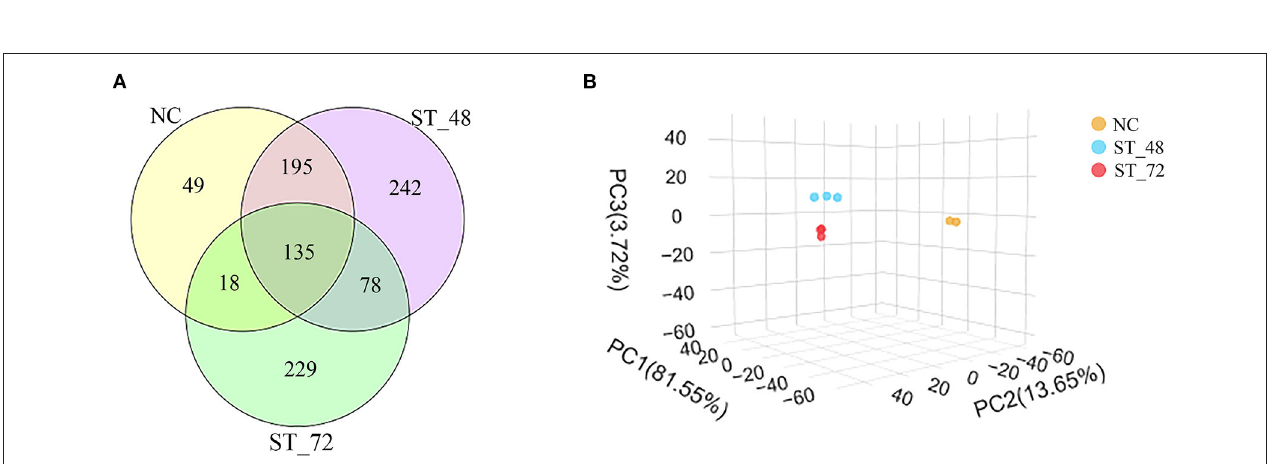
30 genera were selected for mapping ( Figure 4B ). Lactobacillus abundance was highest in the NC group (94.09%). A similar ST_72 groups (49.45 and 49.53%, respectively),